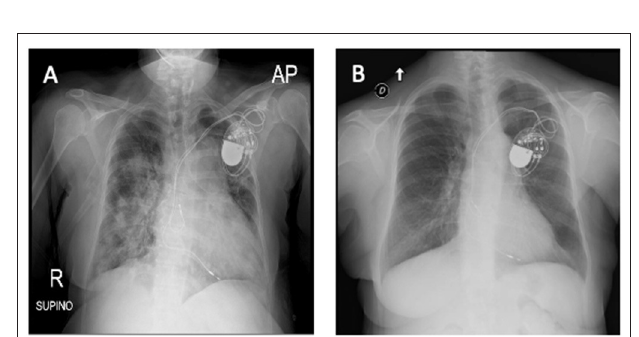
FIGURE 2 | (A) X-ray at hospital admission describing parenchymal thickening and a bilateral widespread pulmonary interstitial involvement. (B) Tocilizumab administration led to bilateral improvement with a decrease in the density and in the extension of lung thicknesses